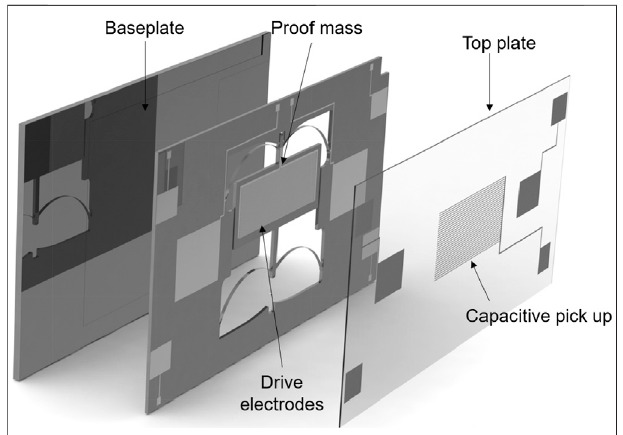
FIGURE 3 | Schematic of microelectromechanical systems gravimeter showing the three-layer structure of the